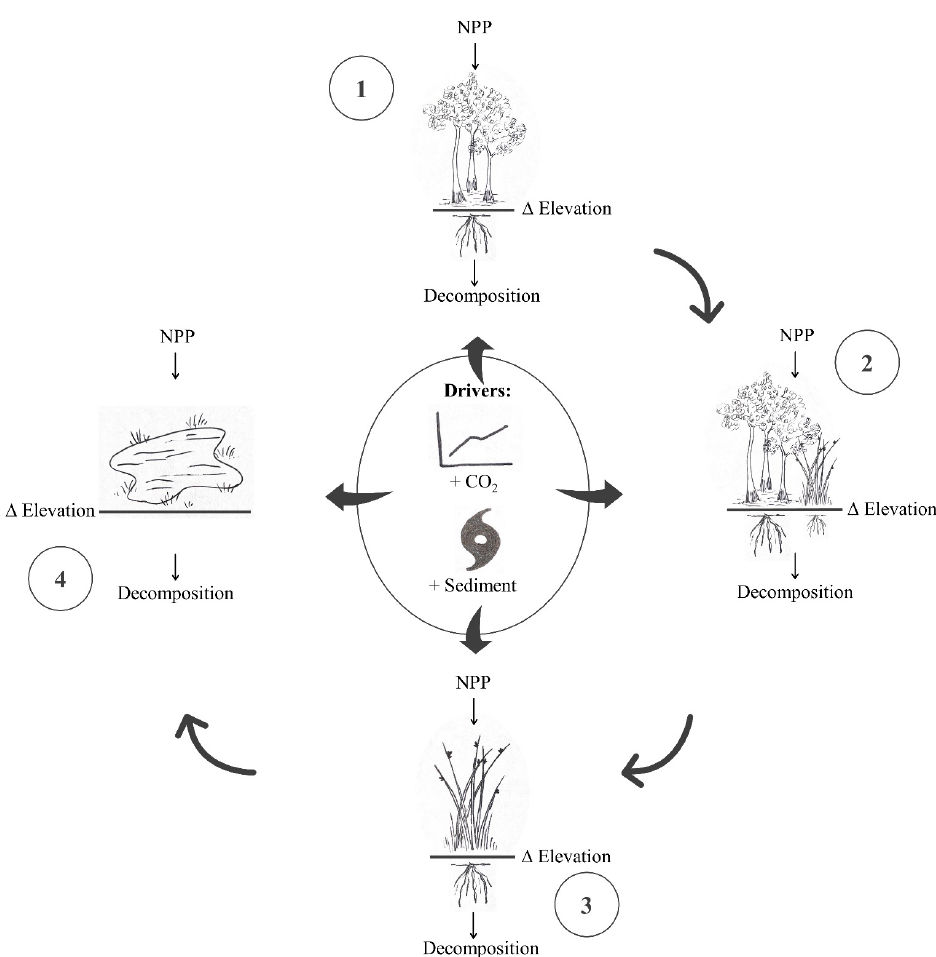
Figure 1. Conceptual experimental design. Organic matter inputs through net primary production (NPP) counter-balance organic matter exports through decomposition resulting in net elevation surplus or deficit in four wetland communities along a landscape-scale transition (clockwise) from (1) freshwater forested wetland to (2) transitional mixed forest/marsh, to (3) marsh, to (4) mudflat. Experimental manipulations (elevated CO 2 and sediment deposition) simulated future hurricane sediment deposition events in a CO 2 -enriched environment.